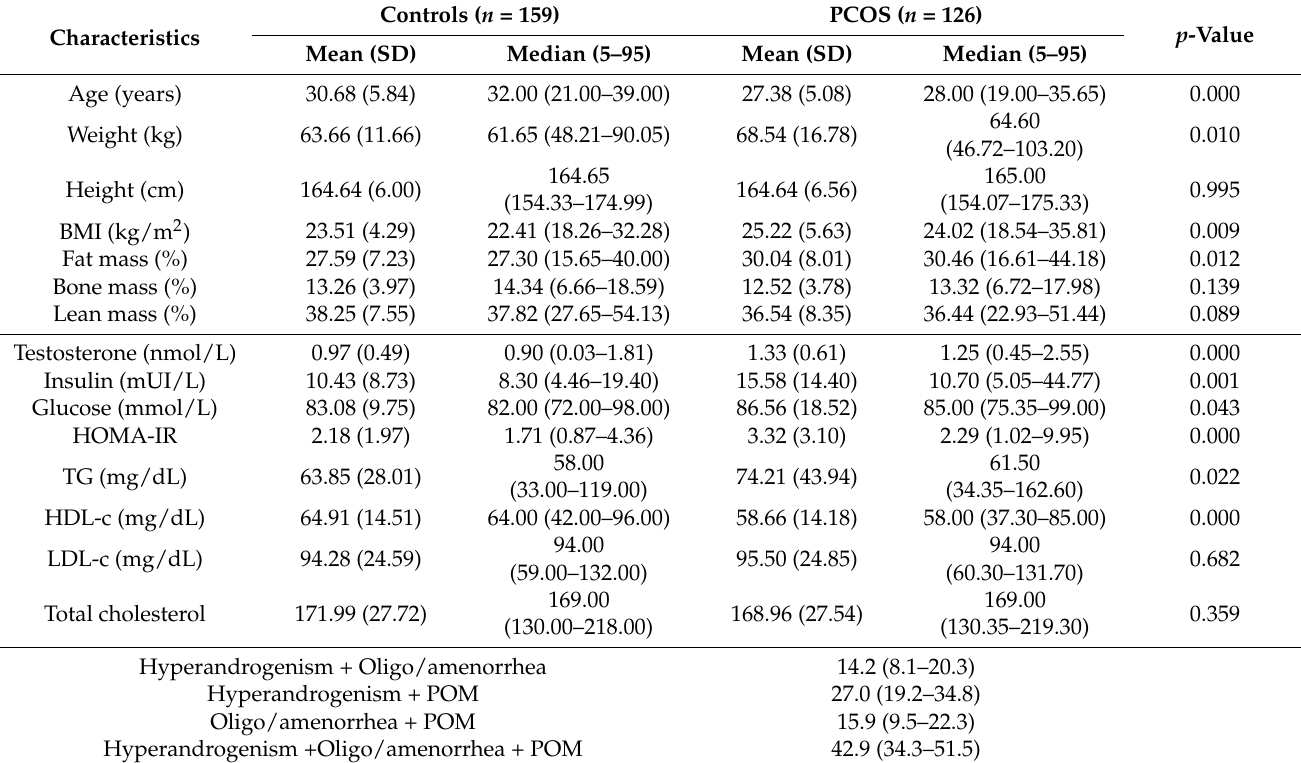
Table 1. Anthropometric measurements and analytical determinations in PCOS and control